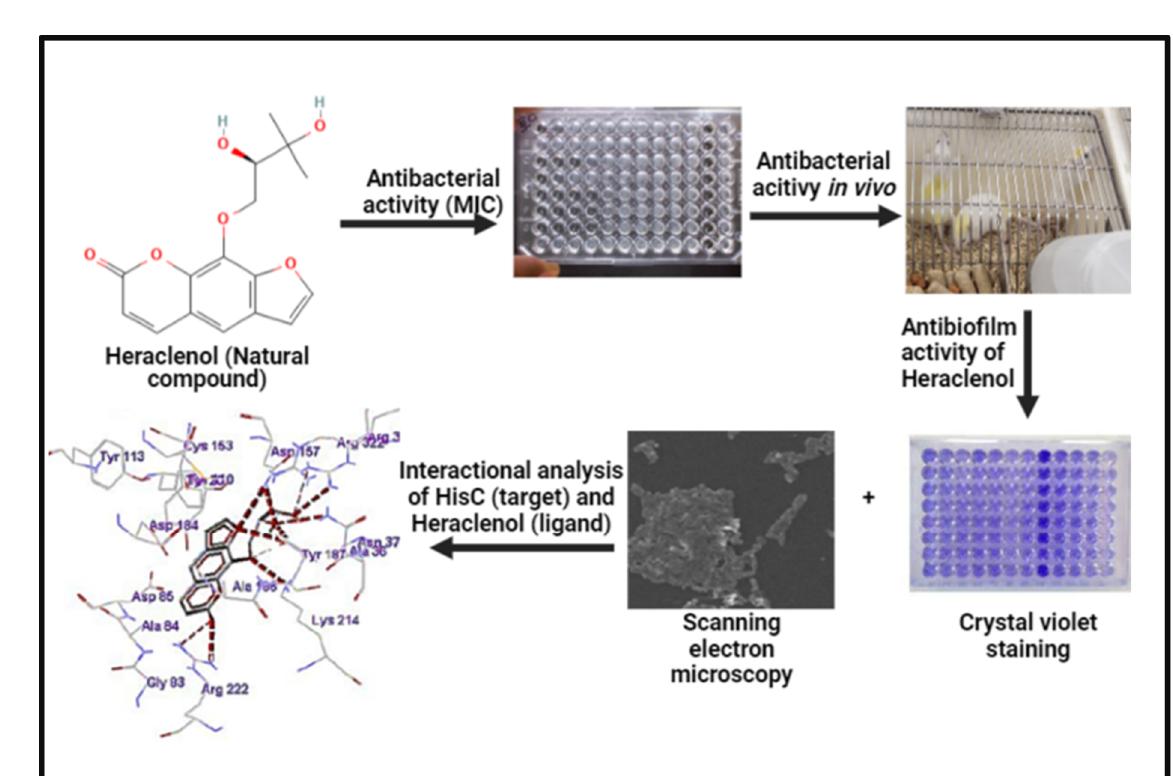
Figure 1. Graphical representation of the methodology of the present study.